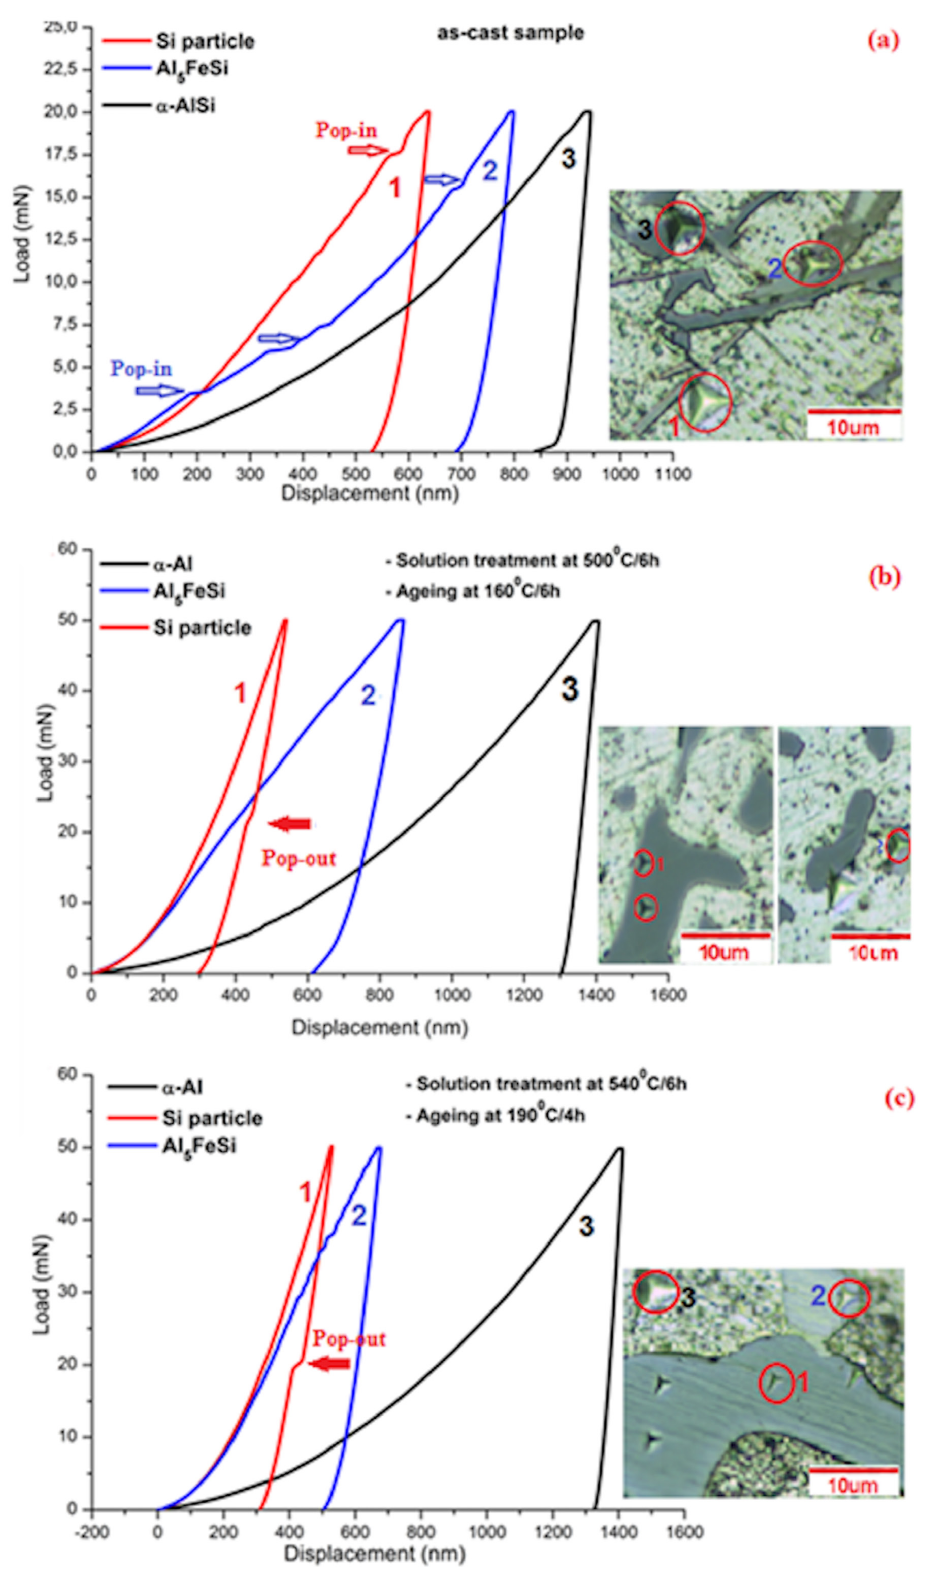
Figure 9. Load-displacement curves and indented surface microstructure of the Al-Si-Cu alloy (a) as-cast sample (b) 500 o C/6h and ageing 160 o C/6h (c) 540 o C/6h and ageing at 190 o